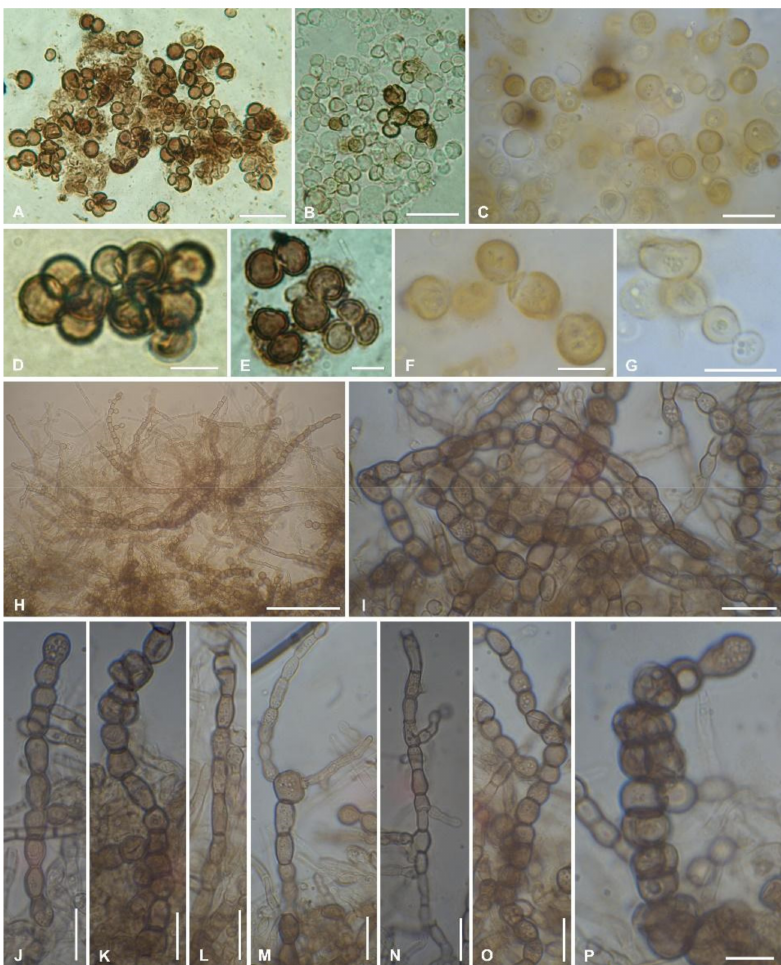
Figure 4. Morphological characters of Antarctolichenia onofrii analyzed in the isolated strains MNA- CCFEE5176 ( A , B , D , E ); MUT 6552 (type strain) ( C ); MNA-CCFEE6163 ( F , G ); and MUT 6495 ( H – P ). Both isodiametric, yeast-like cells with a thick, melanized cell wall ( A – G ) and filamentous branching hyphae with a thinner cell wall ( H – P ) are observed. The filamentous hyphae are composed of isodiametric-to-rectangular cells ( H – P ). Scale bars: ( H ) 50 µ m; ( A , B ) 20 µ m; ( C , G , I – O ) 10 µ m; and ( D , E , F , P ) 5 µ